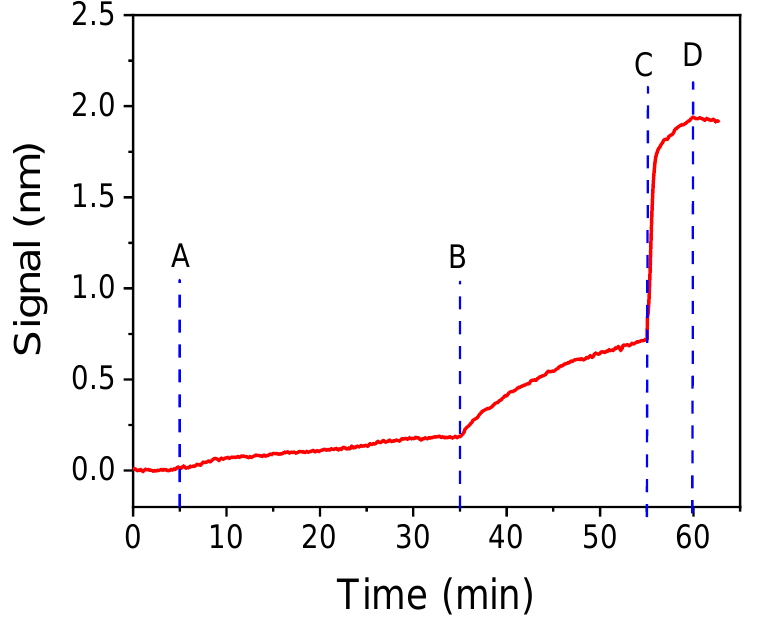
Figure 2. Real-time signal obtained from a chip functionalized with OTA-OVA conjugate (200 µ g/mL) upon running: assay buffer (start to point A); a 1:1 ( v / v ) mixture of zero calibrator with a 1.0 µ g/mL rabbit anti-OTA antibody solution (A,B); a 1:200 dilution of biotinylated secondary antibody (B,C); and a 10 µ g/mL streptavidin solution (C ,D).